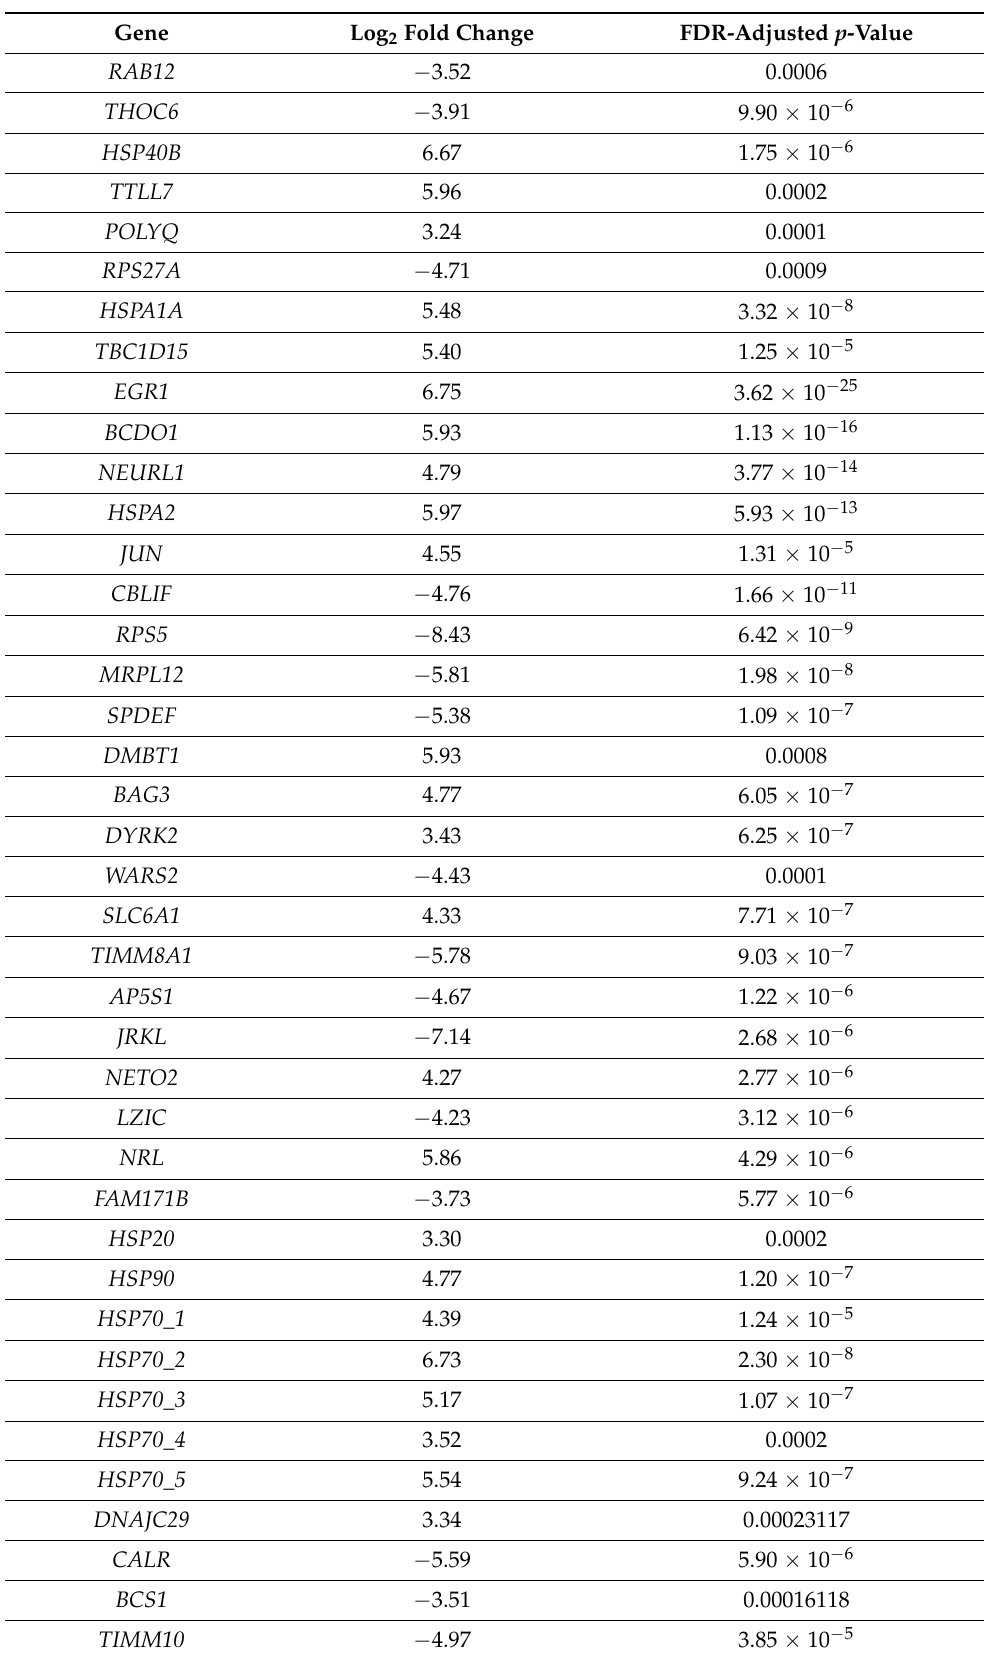
Table 5. All genes mentioned in the body of this text and their respective changes in